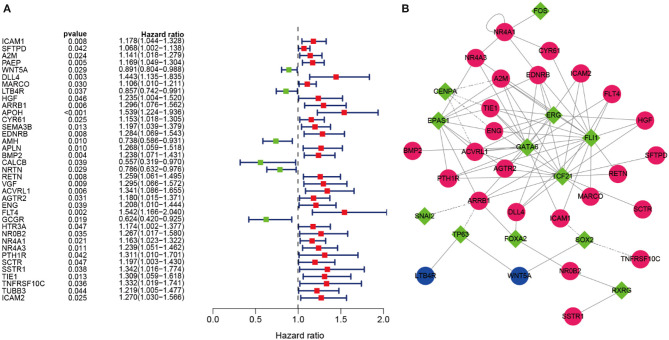
OS-related DEIRGs and TFs-IRGs regulatory network. (A) The forest map of OS-related DEIRGs in LUSC. Red and green dots indicate the high and low-risk, respectively. (B) Regulatory network between prognosis-related DEIRGs and DETFs in LUSC. The red and blue circles indicate the high and low-risk DEIRGs, respectively. The green diamonds indicate DETFs. Solid and dashed lines in the network showed that there is a positive and negative correlation between prognosis-related DEIRGs and DETFs.